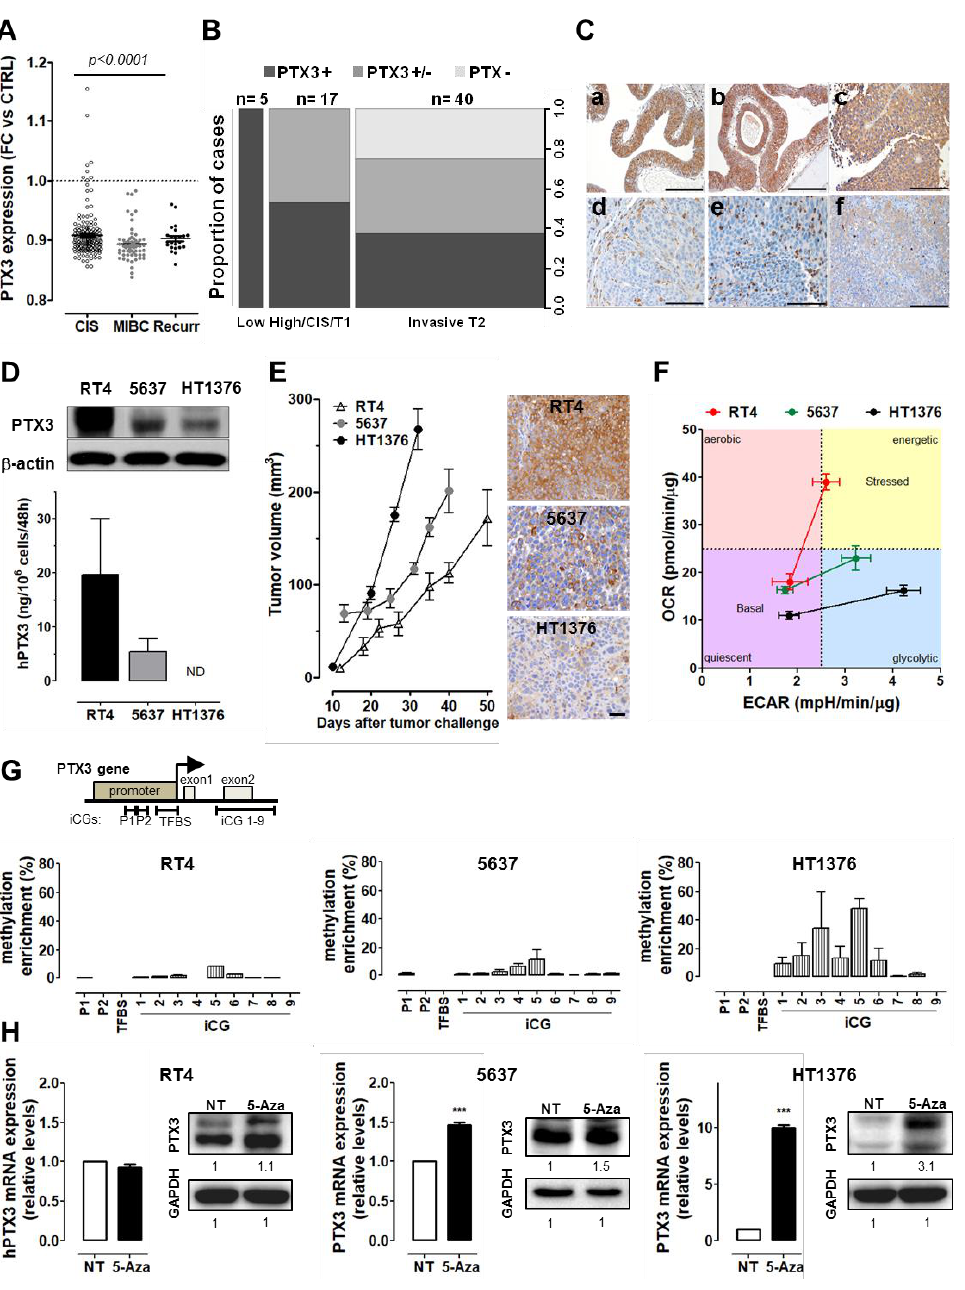
Figure 1. Long pentraxin-3 (PTX3) expression is related to tumor grade in human bladder cancer (BC) samples and tumor cell lines. ( A ) Scatter Plot of PTX3 expression levels in human BC samples compared with normal tissue, data obtained from Gene Expression Omnibus (GEO). ( B ) Spine plot graph showing the association between PTX3 immunostaining and tumor grade in human BC samples p = 0.0019; n = number of cases. ( C ) Human low-grade papillary bladder carcinomas (LGP-BC; n = 3) ( a – c ) and high-grade muscle invasive bladder cancer (MIBC; n = 3) ( d – f ) stained for PTX3. Magnification: 20 ×; scale bar = 100 µM. ( D ) Quantification of PTX3 levels in BC cell lysates (Western Blot, upper panel) or medium (ELISA, lower panel). ( E ) Tumor growth in vivo of RT4, 5637, and HT1376 cells, and IHC for PTX3 of the explanted tumors. scale bar: 50 µM. ( F ) Characterization of the energy metabolism of BC cells by Seahorse Mito Stress Test (OCR = oxygen consumption rate, ECAR = extracellular acidification rate). ( G ) Percentage of methylation enrichment of the PTX3 promoter in BC cell lines ( G ) and quantification (by qPCR and Western blot) of PTX3 expression levels after treatment with 5-Aza-2-deoxycytidine (5-AZA) ( H ). Data are expressed as mean ± SEM. *** p <